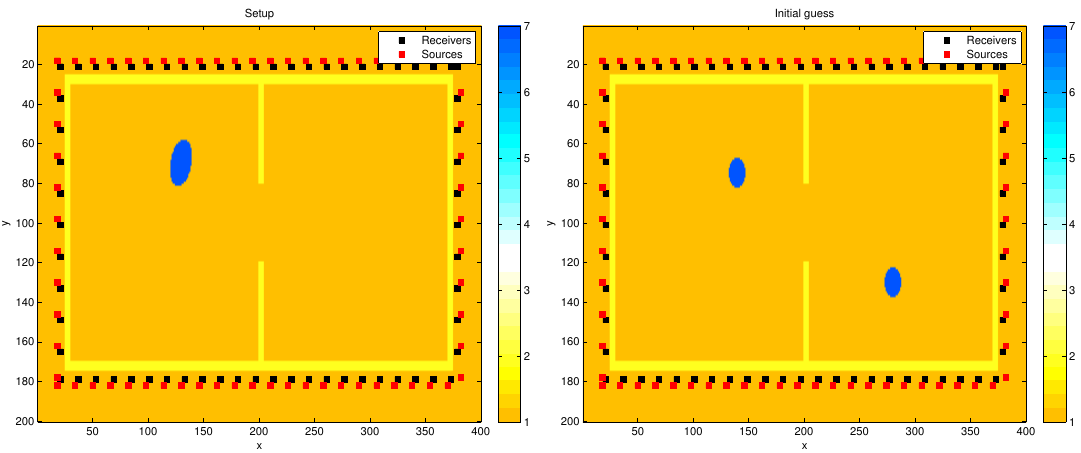
Figure 1. To the ( left ): example setup considered. To the ( right ): initial guess adopted in the